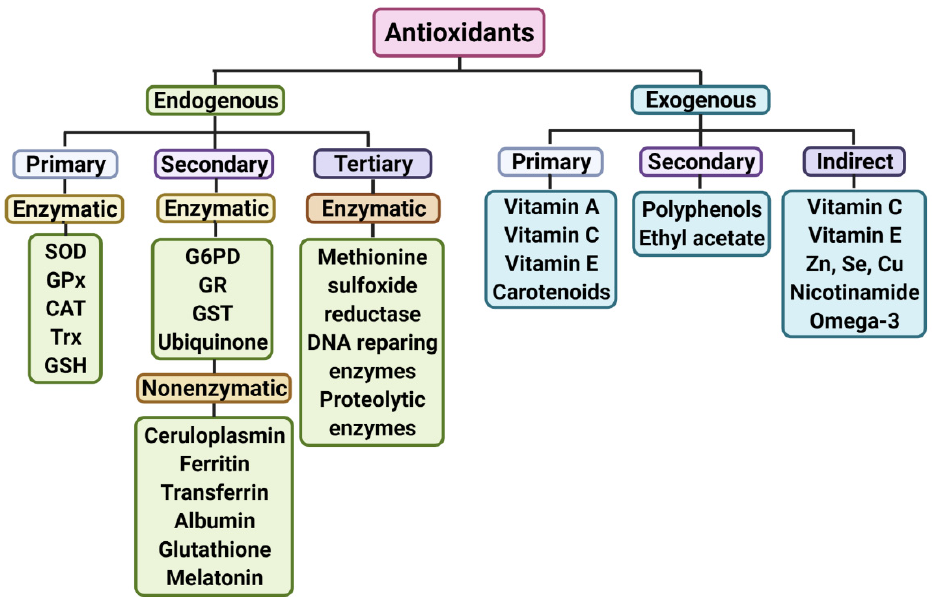
Figure 1. Endogenous and exogenous functional components of the antioxidant system in humans. The figure shows antioxidant molecules organized according to its origin that can be endogenous, which are synthetized by the organism, or exogenous, which have to be consumed in the diet. In addition to their source (endogenous or exogenous), antioxidants may be classified according to their antioxidant action into primary, secondary, and tertiary. Primary antioxidants are chain-breaking antioxidants that accept free radicals terminating the propagation of oxidative reactions and transform free radical species into more stable and less reactive products. Secondary antioxidants are radical scavenging molecules, and they have a preventive role in suppressing chain reaction initiation. Tertiary antioxidants are enzyme systems that can repair biomolecules that have been damaged by oxidation. Additionally, antioxidant action could be direct or indirect. Indirect antioxidants enhance many of the direct primary and secondary antioxidants. Finally, antioxidants could be enzymes or non-enzymatic molecules. SOD: superoxide dismutase, CAT: catalase, GPx: glutathione